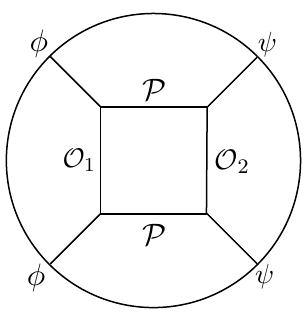
Figure 6 . Pomeron box graph with a generic, t -channel, double-trace